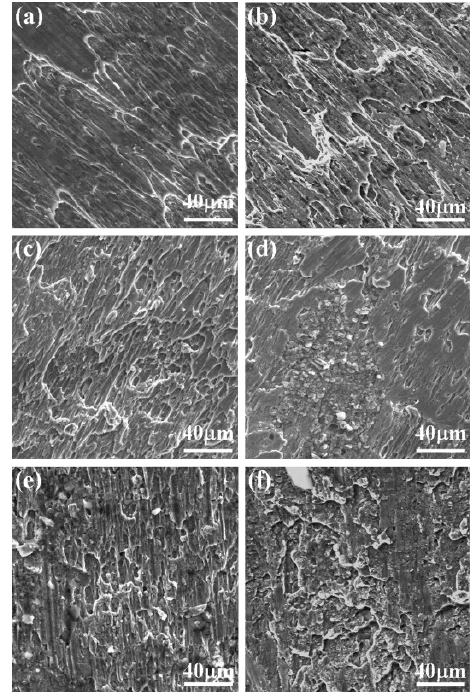
Figure 24. Fracture surfaces of S15C steel deformed at ( a ) 5 × 10 4 s − 1 and ( b ) 2 × 10 5 s − 1 ; S50C steel deformed at ( c ) 5 × 10 4 s − 1 and ( d ) 2 × 10 5 s − 1 ; and SKS93 steel deformed at ( e ) 5 × 10 4 s − 1 and ( f ) 2 × 10 5 s − 1 [126] .